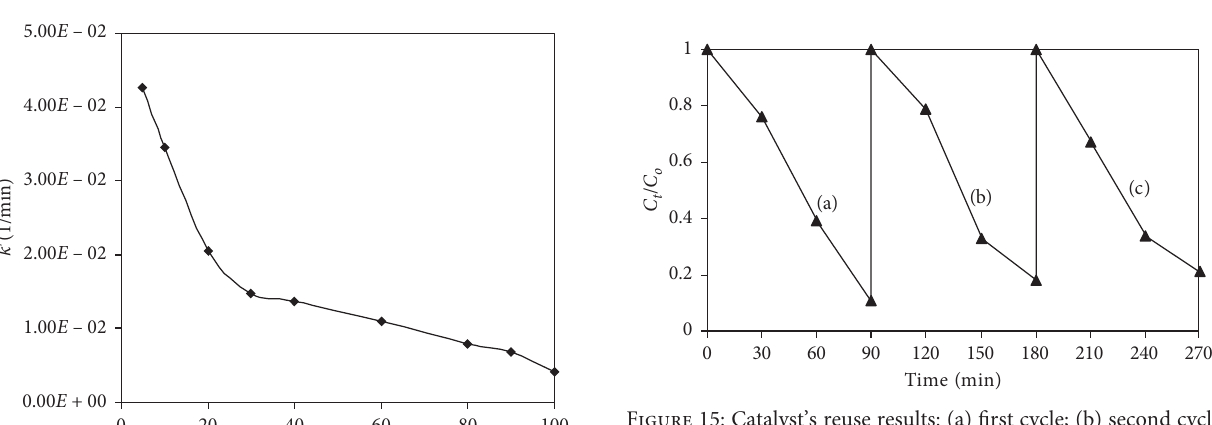
Figure 14: Schematic mechanism of photocatalytic degradation of RhB by C, N-TiO 2 .